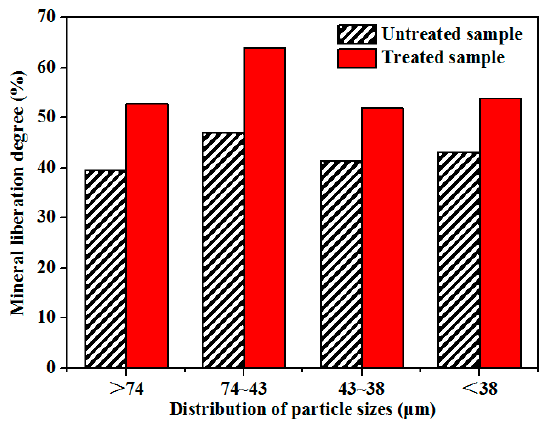
Figure 8. Degree of mineral liberation of samples treated and untreated with HVEP treatment.